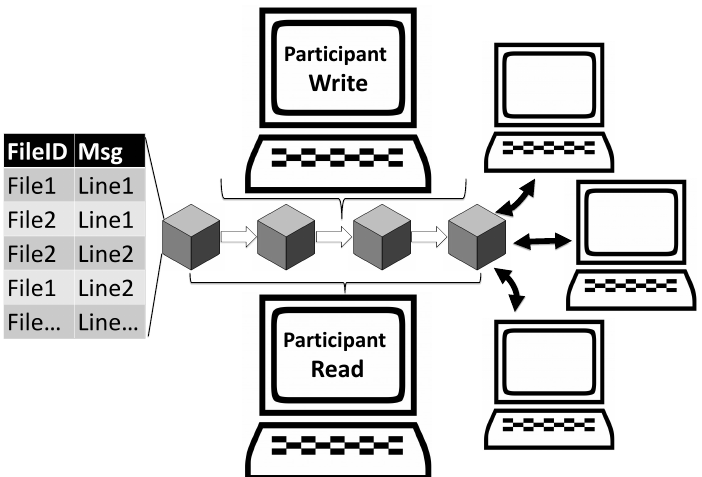
Figure 1. Log files are files in which information is appended over time. In each time period, new entries are added to some files. Our system treats these updates as transactions containing a FileID to which a given message (Msg) relates. These are combined into a block and stored on the blockchain. To read a file from the blockchain, the various transactions associated with a given FileID are collected and appended